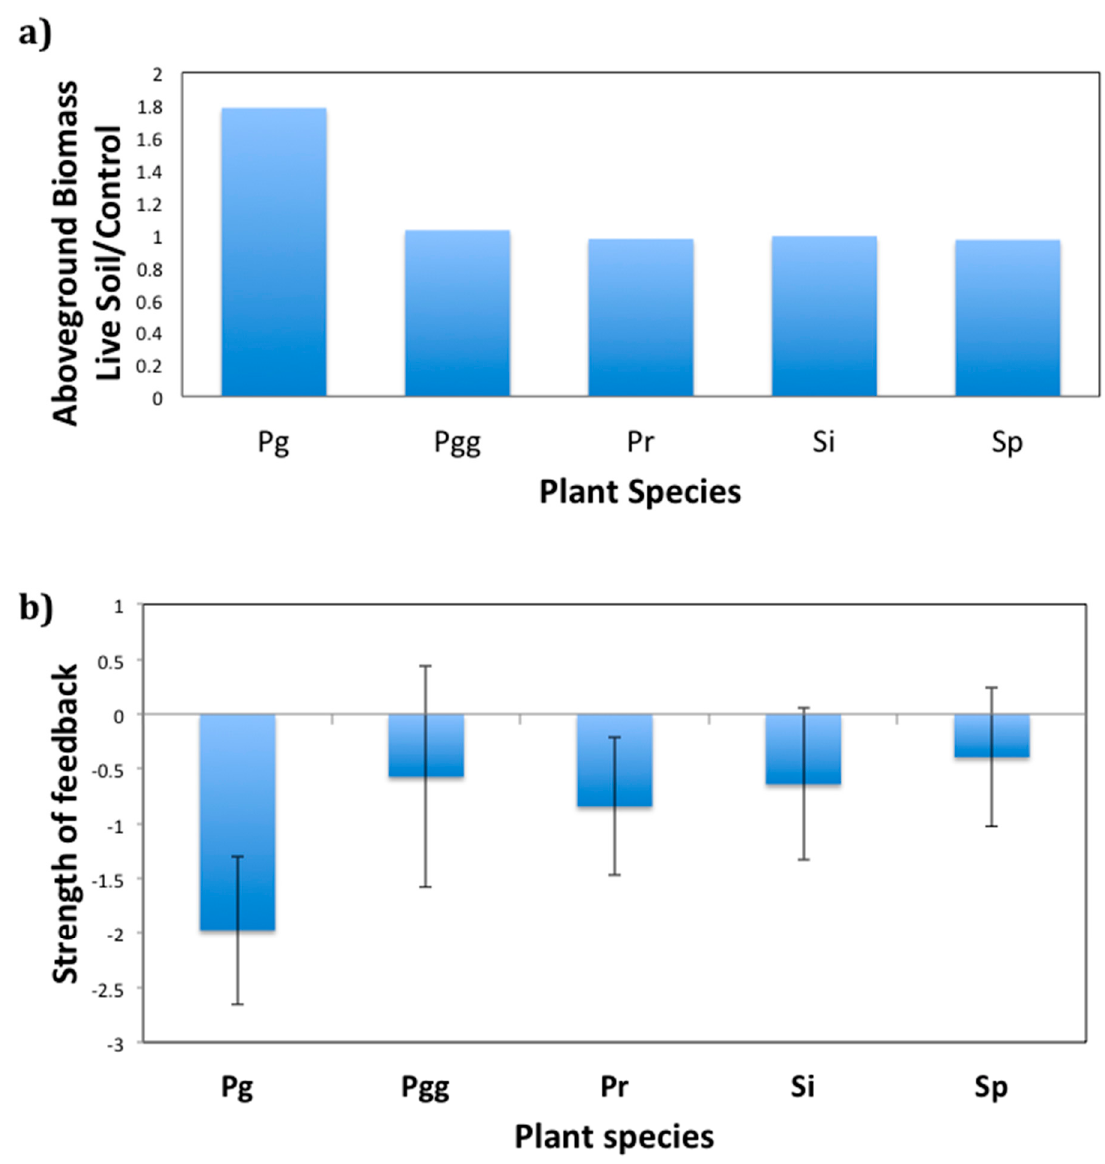
Figure 3. ( a ) Aboveground plant biomass and control ratios of feedback experiment and ( b ) variation in the strength of negative feedback through soil biota among the five seedling species using aboveground biomass. Errors and means that differ from zero are indicated by asterisks. Plant–soil feedback values give an indication of the effect of conditioned soil on plant growth, with positive values indicating better performance and negative values indicating low performance.